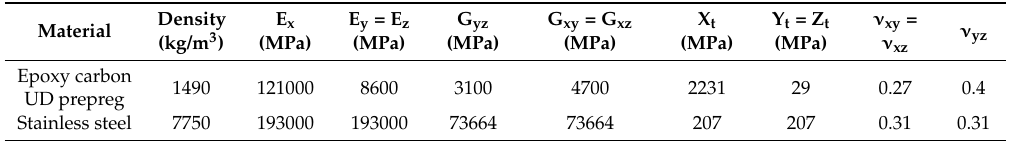
Table 2. Properties of materials used in modeling the turbine.